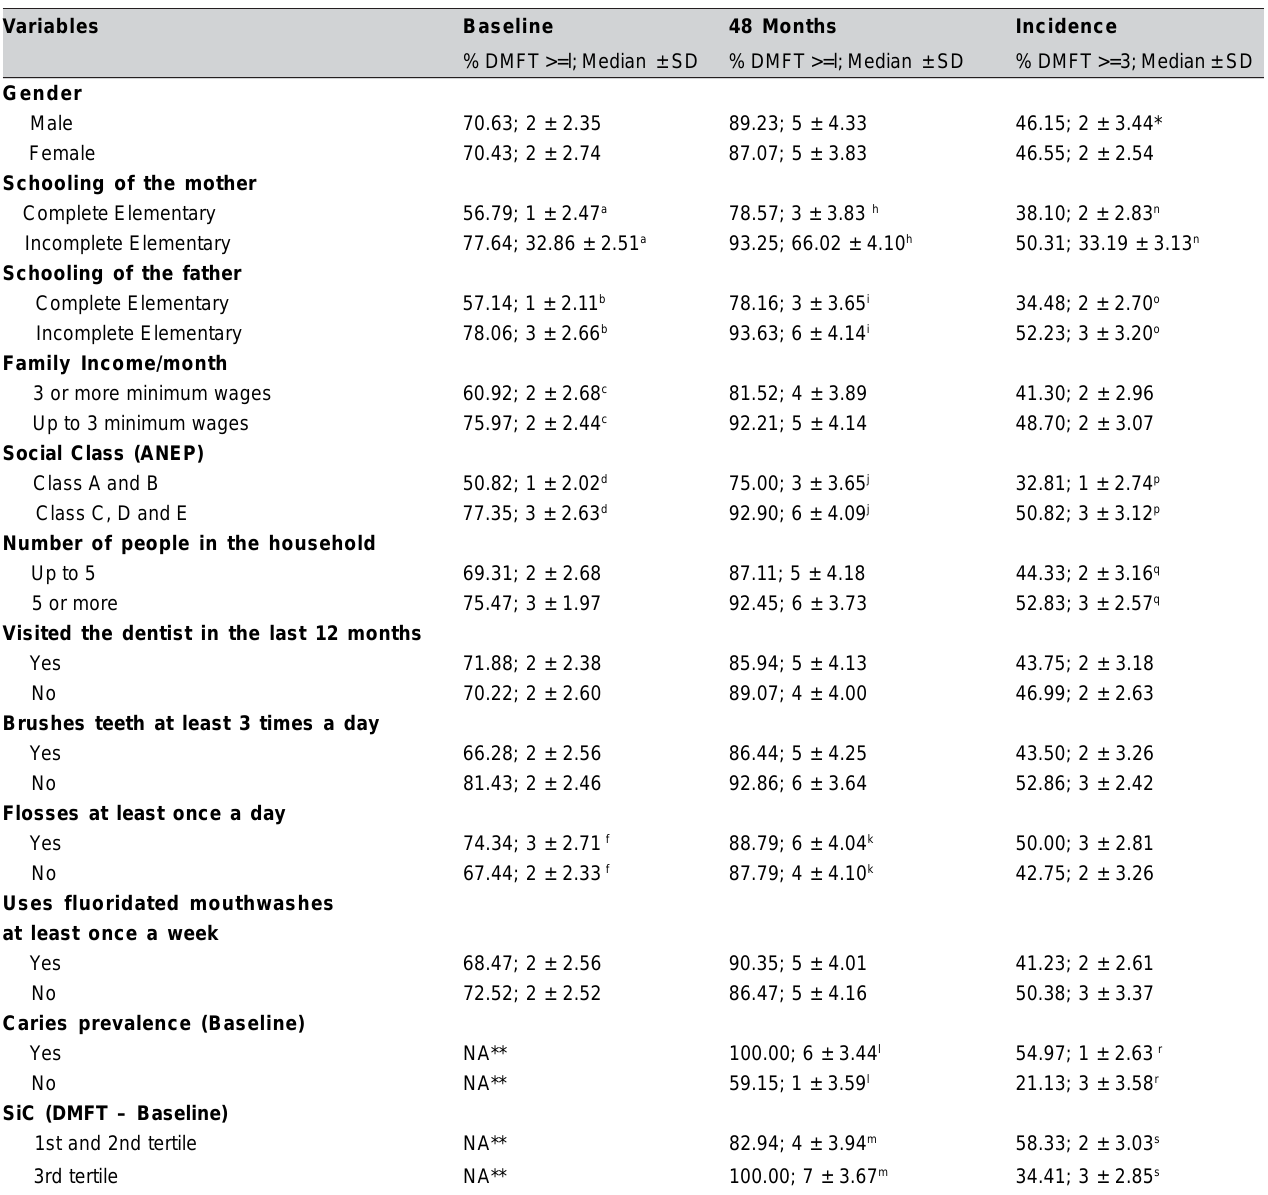
Table 2 - Median and standard deviation (SD) of the DMFT according to risk variables, in adolescents (Água Doce-SC,